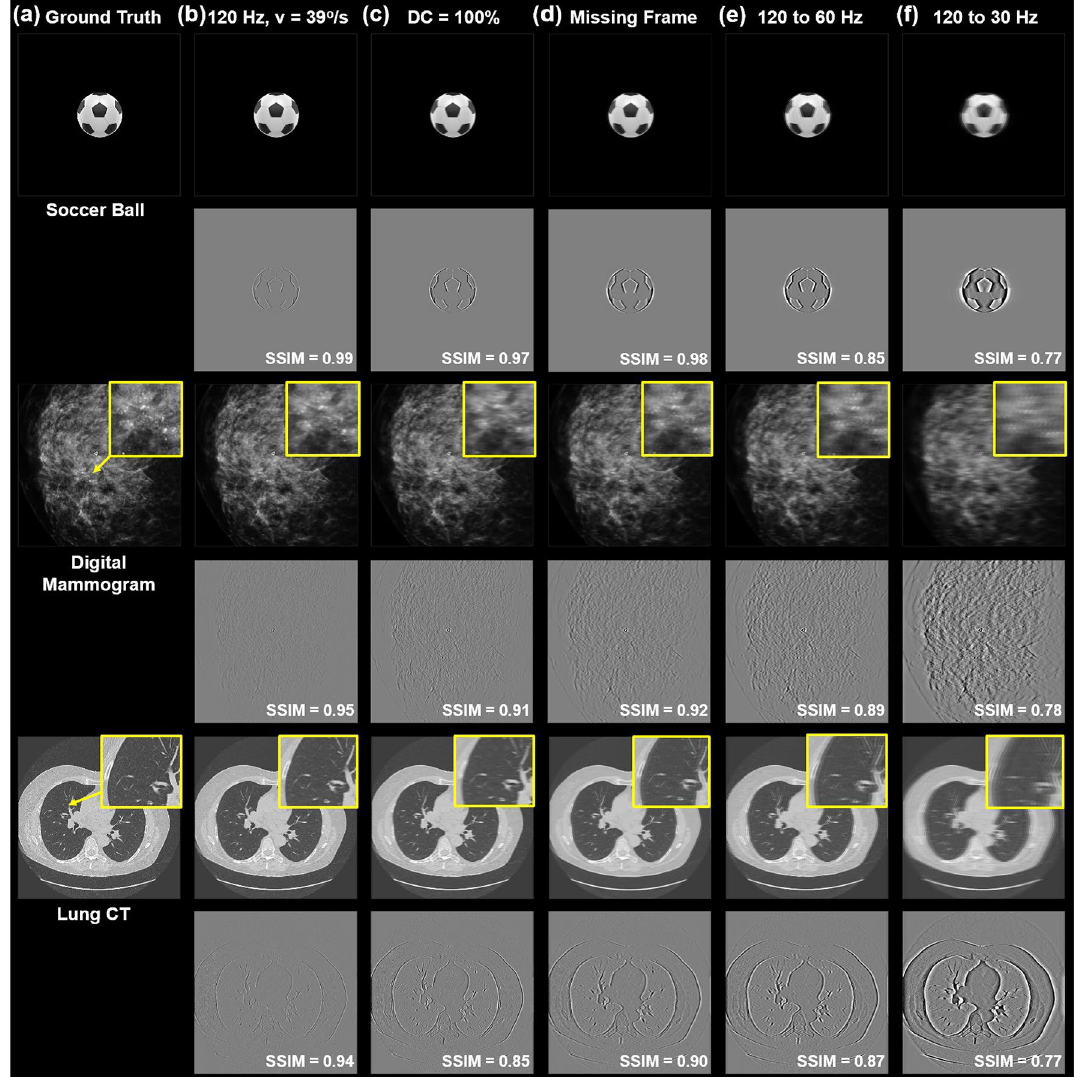
Figure 11. Visualizations of motion image artifacts and motion image errors (difference images with respect to static images) of a soccer ball (first row), a digital mammography image (second row) and a lung CT slice (third row) in motion: ( a ) referencing static images, ( b ) moving scenes at 39°/s using a pulsed 120 Hz refresh rate, ( c ) a continuous emission with 100% duty cycle, moving images with a missing frame ( d ) and frame rate reduction from 120 Hz to 60 Hz ( e ) and 30 Hz ( f